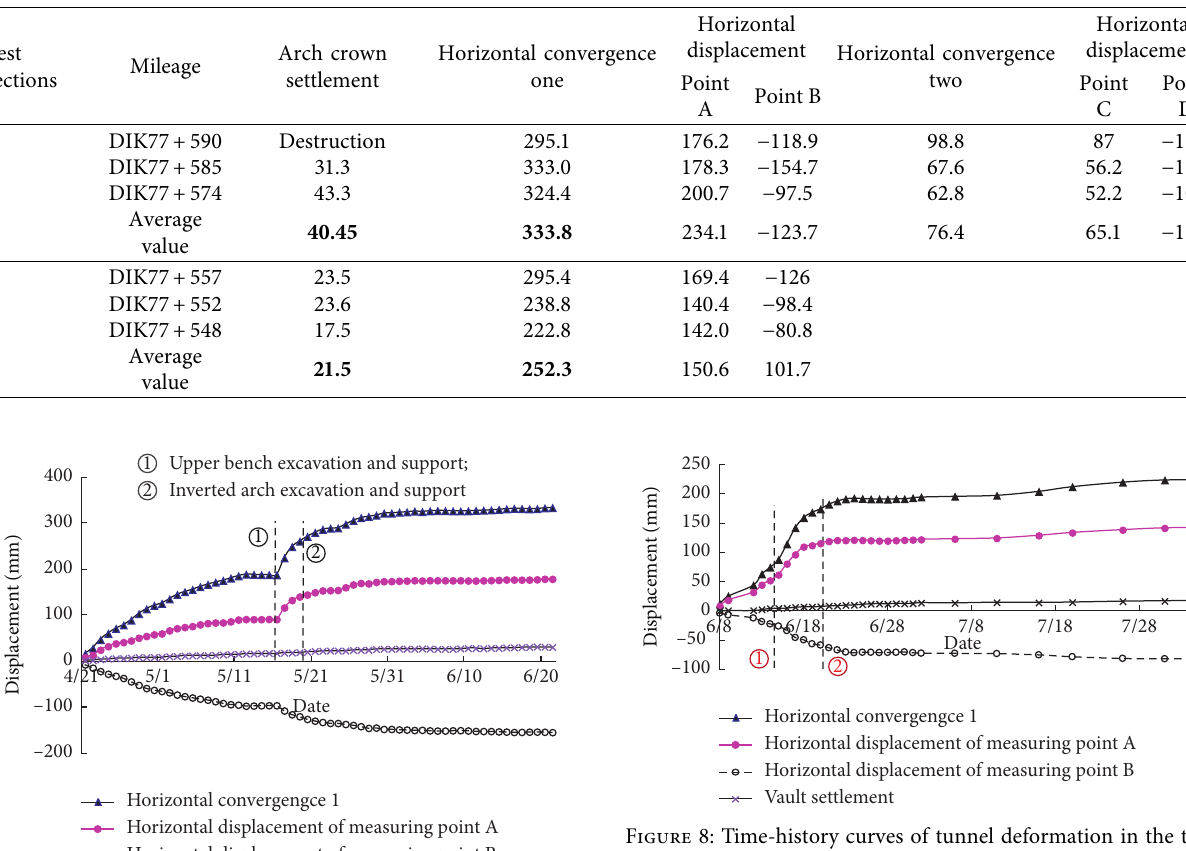
Figure 6: The cracking of initial support and the deformation of steel frame in the test section 2. (a) The cracking of initial support. (b) The deformation of steel Table 2: Measured results of displacement (mm).